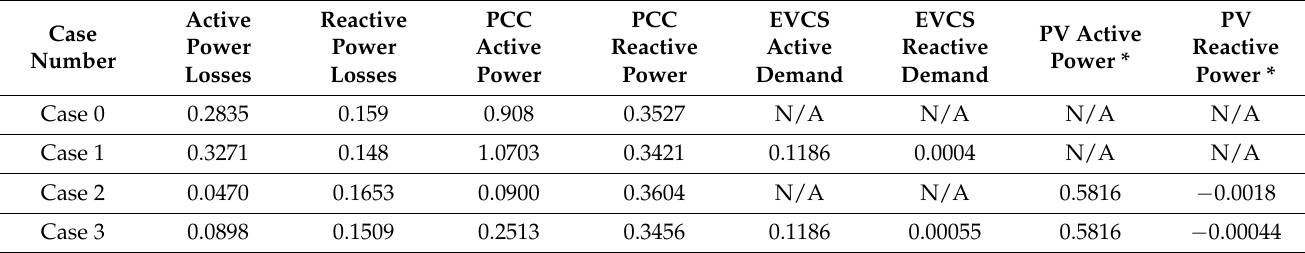
Table 4. Simulation results for the four cases. The numbers reported are the average values for the duration of dispatch (8 h). All values are provided in per unit, based on a base power of 5 MVA.